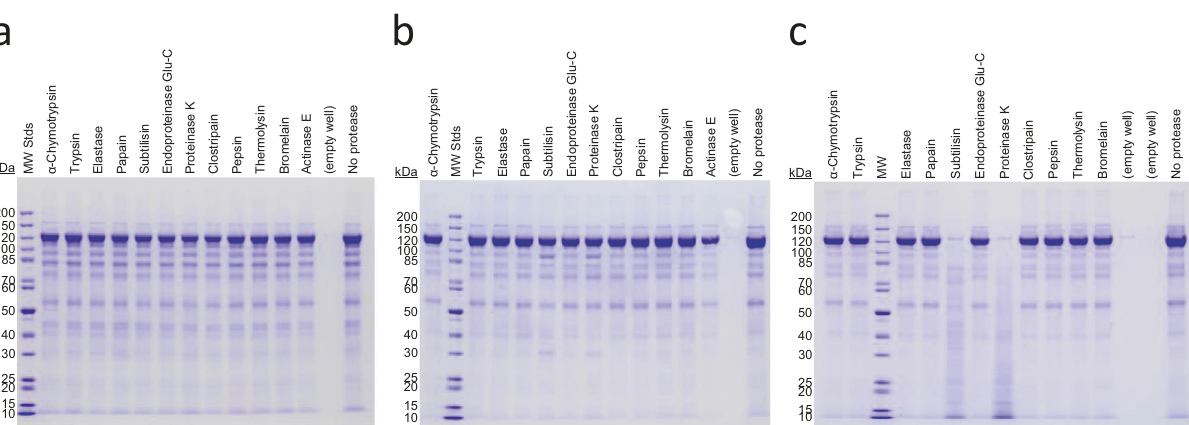
Fig. 4 Treatment of Cry14Ab with proteases. Cry14Ab was incubated with various proteases at a protease-to-protein weight ratio of 1:100 at 37 °C for 2 h at three pH values, and then run on SDS – PAGE and stained with Coomassie blue dye. The digestion was performed three times and gave similar results each time. a 20 mM sodium acetate pH 5.0, 150 mM NaCl; b 5 mM HEPES (4-(2-hydroxyethyl)-1-piperazineethanesulfonic acid) pH 7.5, 250 mM NaCl;